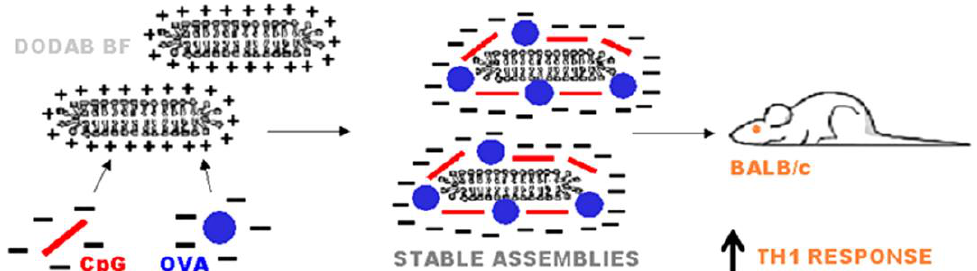
Figure 7. Schematic representation of cross sections for DODAB bilayer fragments (DODAB BF) used for carrying ovalbumin (OVA) and CpG agonist of Toll-like receptor 9. The final assemblies were anionic and directed excellent Th1 response in mice immunized subcutaneously. Curiously, addition of CpG to the assembly did not improve the immune response; DODAB was effective by itself. In addition, the nanosize of the assemblies was more important than the charge. Reprinted from [16] with permission from Elsevier, Copyright 2012.